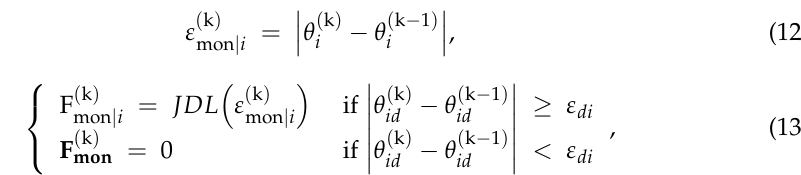
Figure 3. Flow chart of the generalized Jamming Detection Logic (JDL).